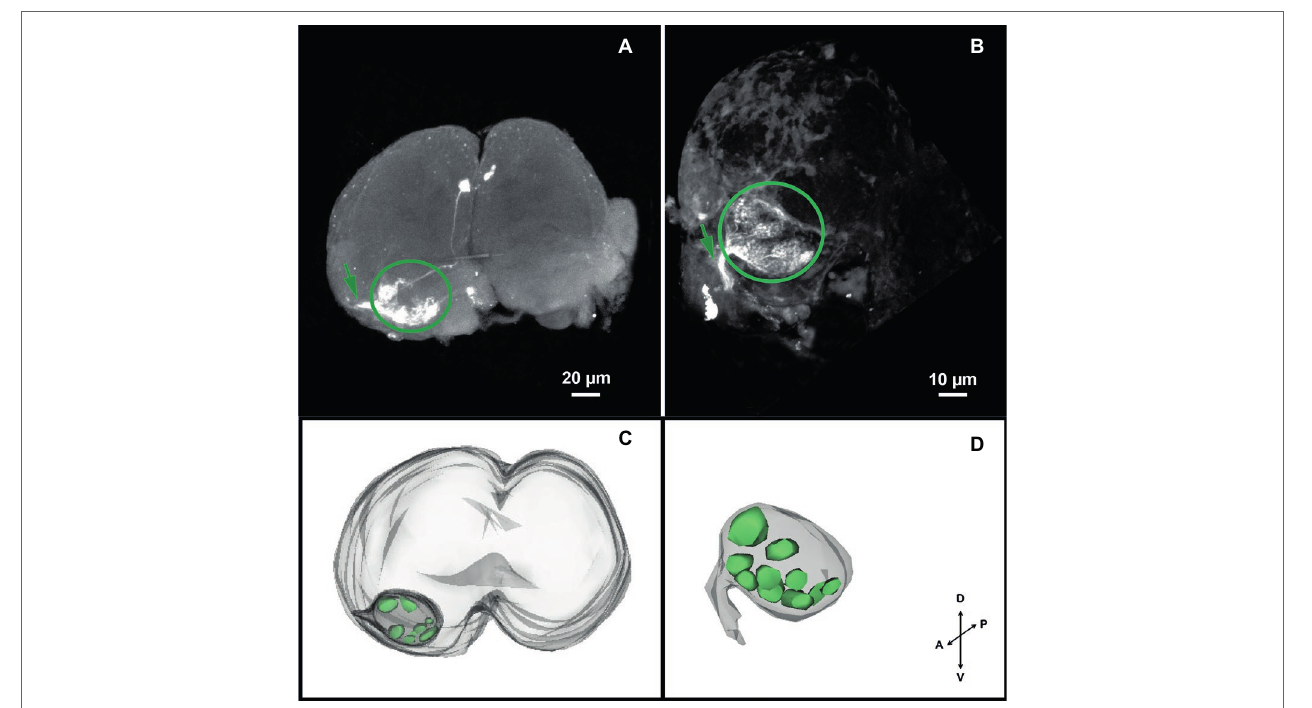
FIGURE 2 | Antennal projections to the brain and antennal lobe organization of head lice. (A,B) Anterior views of the brain, showing neurobiotin antennal backfills. An antennal nerve (arrow) reaches the brain antero-ventrally and innervates the ipsilateral antennal lobe (circle), where diffuse globular structures were identified. (C,D) 3D reconstruction of the AL where 8–10 glomerular-like structures were evinced. Orientation bars: D , dorsal; V , ventral; P , posterior; A ,